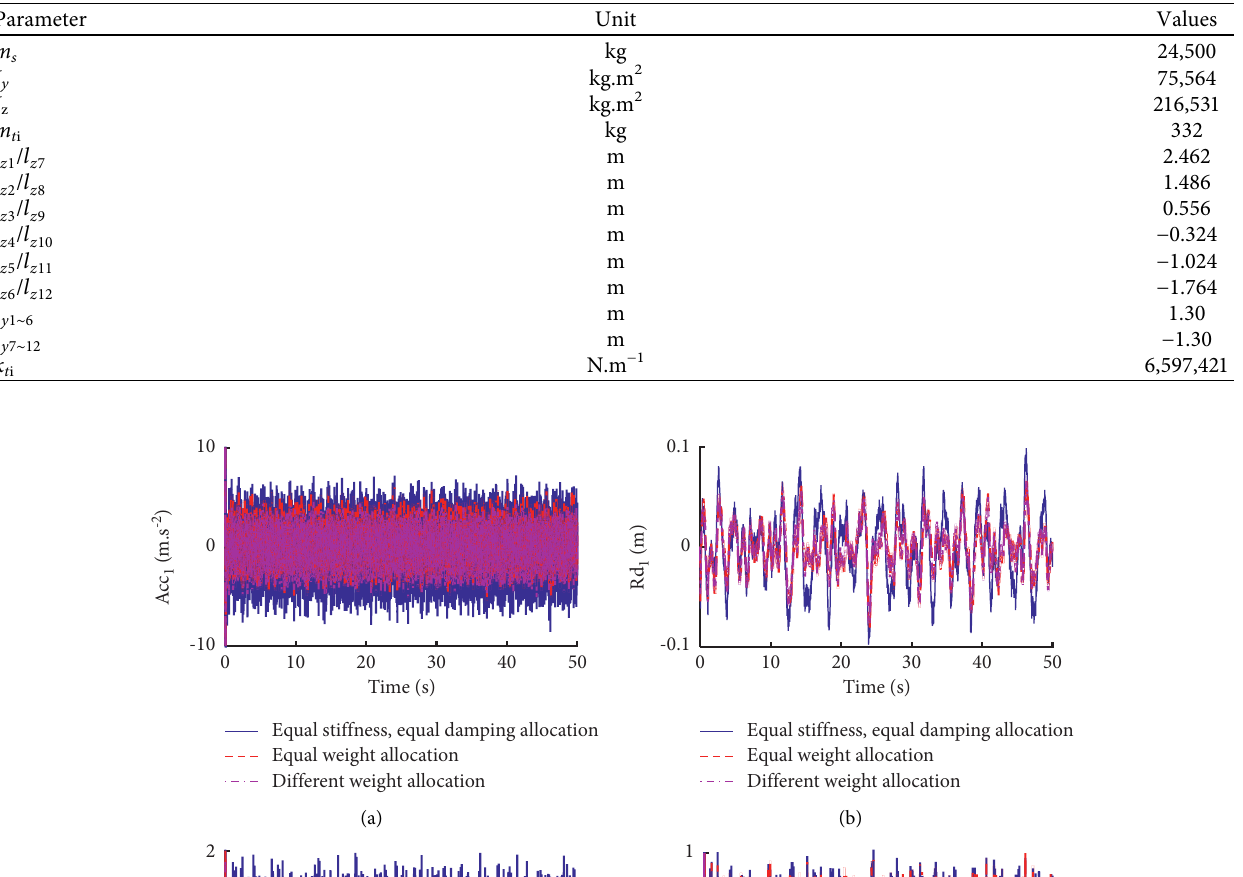
Table 5: Main parameters of the tracked